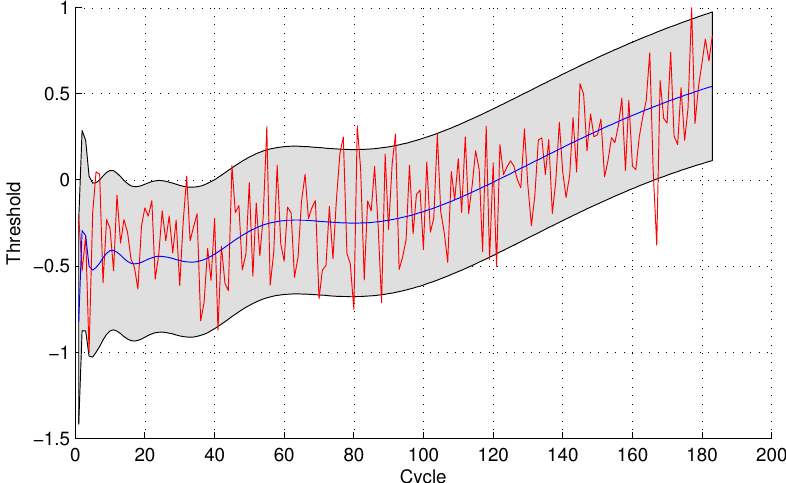
Figure 10. Anomaly detection for sensor data set 3 with GPR for the observing sensor